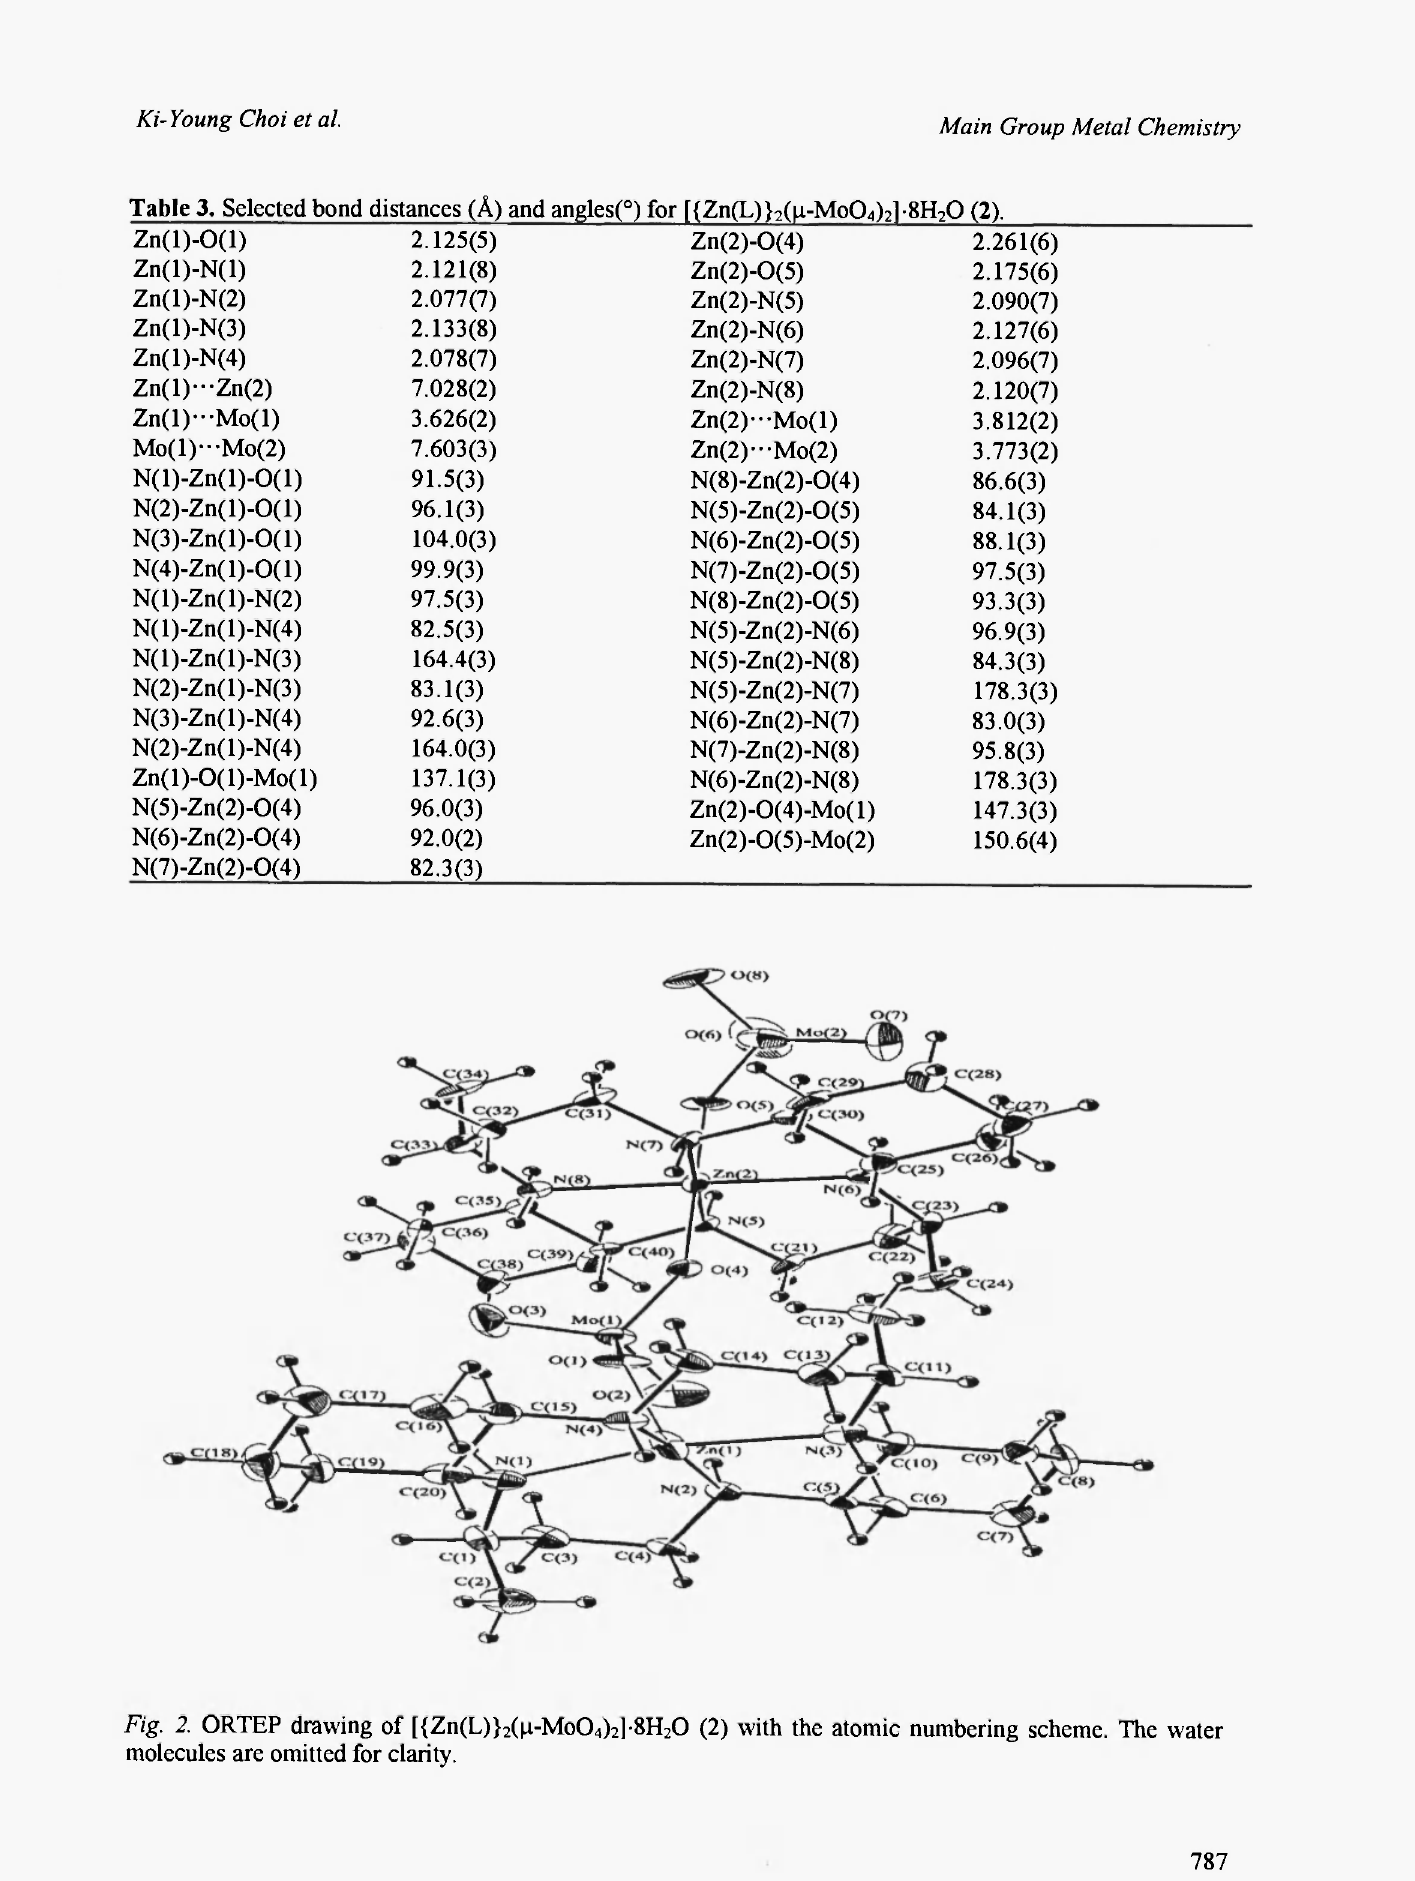
Fig. 2. ORTEP drawing of [{Zn(L)} 2 (μ-Μο0 4 ) 2 ] ·8Η 2 0 (2) with the atomic numbering scheme. The water molecules are omitted for